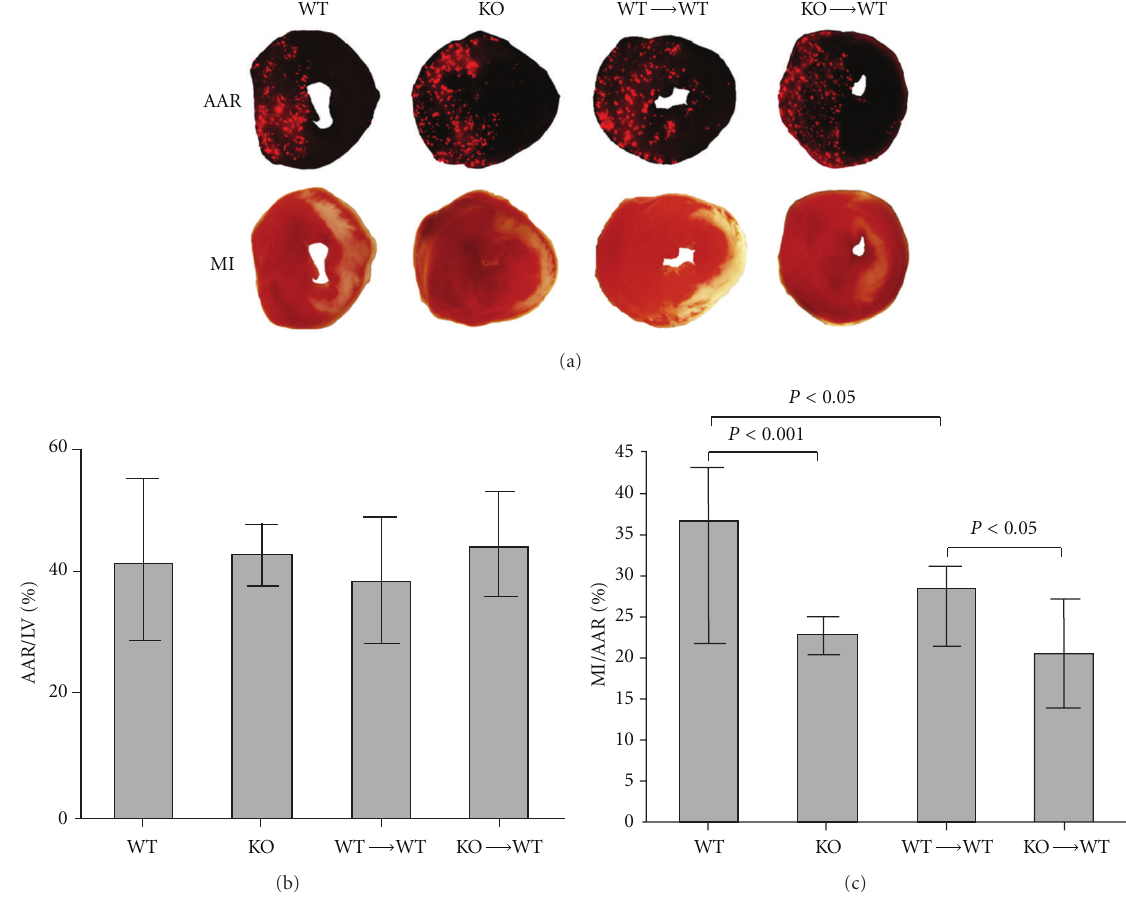
Figure 3: Decreased MI sizes in MyD88-knockout (KO) and KO → WT chimeric mice compared with wild-type (WT) and WT → WT chimeric mice. Mice were subjected to 30min of ischemia and 24 h of reperfusion. At the end of reperfusion, animals were euthanized, and area-at-risk (AAR) and MI were analyzed. (a) Representative of triphenyltetra zolium chloride (TTC) staining ( bottom ) and fluorescent microsphere distribution ( top ) of myocardial sections from the 4 groups of mice. The nonischemic area is indicated by red fluorescent staining, area at risk (AAR) by area devoid of red fluorescent light, and infarct area by white. (b) Cumulative data of AAR/left ventricle (LV). (c) Cumulative data of MI/AAR. Each error bar represents mean ± SD of 6–9 mice. (Feng et al . , [100], used with